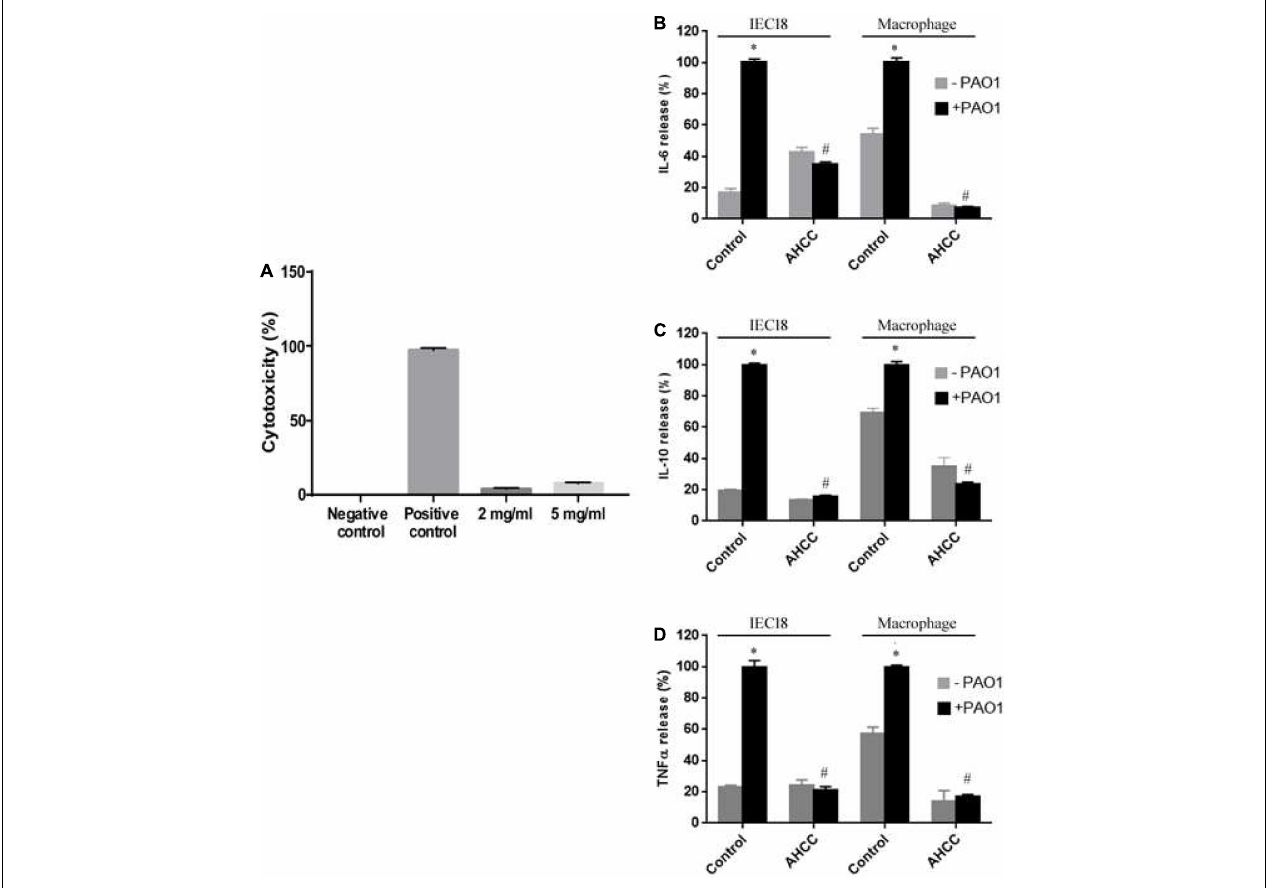
FIGURE 4 | Toxicity and inflammatory response of AHCC R (cid:13) on macrophages and IEC 18 cells. Lactate dehydrogenase (LDH) as a marker of cytotoxicity was measured in the supernatants of IEC18 cells (A) exposed to AHCC R (cid:13) at 2 or 5 mg/mL. (B–D) Cytokine levels in the supernatant of IEC18 or macrophages. Cells were incubated with P. aeruginosa PAO1 (ratio 1/5) for 8 h in either the absence or the presence of 5 mg/mL AHCC R (cid:13) prior to the determination of IL-6 (B) , IL-10 (C) and TNF secretion (D) . Values are means ± s.e.m., n = 6–8; ∗ p < 0.05 vs. cells without bacteria and # p < 0.05 vs. WT in the absence of AHCC R (cid:13) (ANOVA followed by least significance